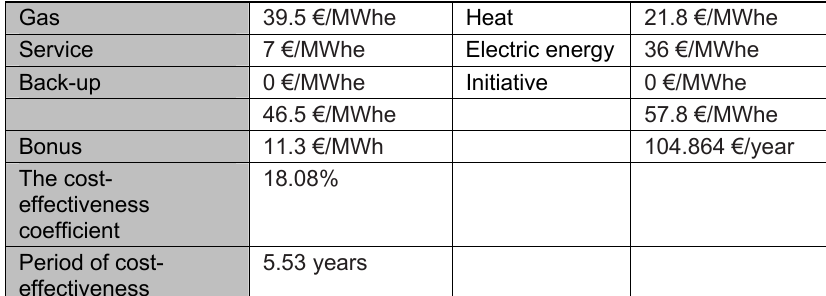
Table 3 – Example of assessing the cost-effectiveness Таблица 3 – Пример прогноза экономической